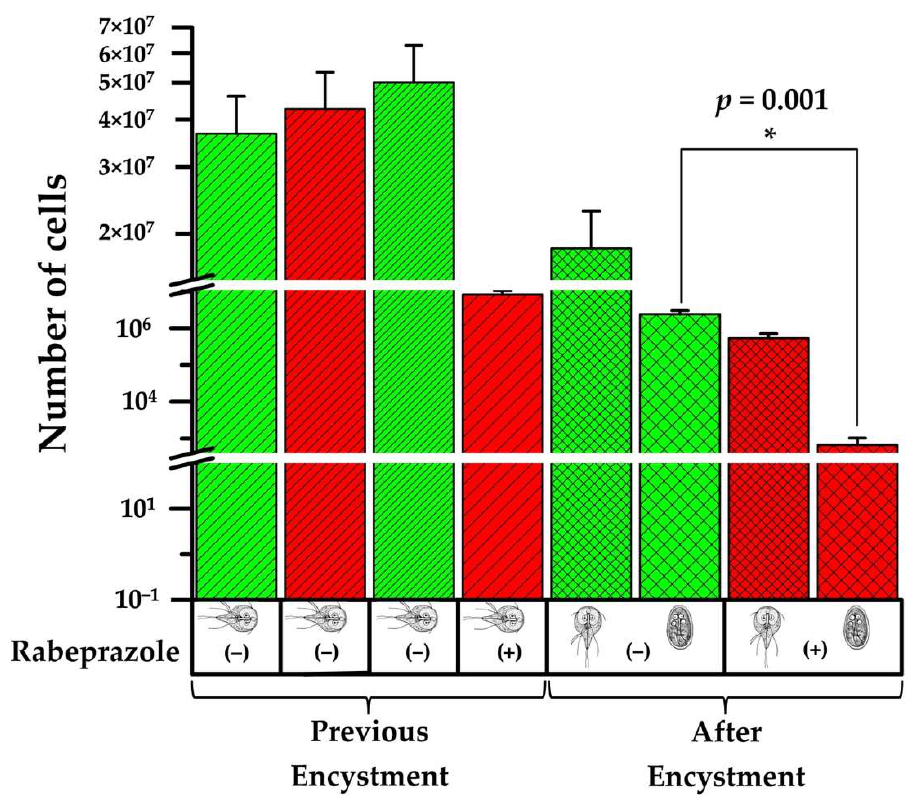
Figure 7. Impairment of Giardia encystment by rabeprazole. Green columns represent the control group (without rabeprazole), and the red columns represent the experimental group (exposed to rabeprazole). From left to right, the first two columns represent the number of cells grown to confluence at the beginning of the experiment in TYI − S − 33 culture medium. The next two columns represent the number of cells grown in pre-encystment culture medium. The last four columns represent the number of cells grown in encystment culture medium. These results are the medium ± SD of three assays, with three technical replicates.